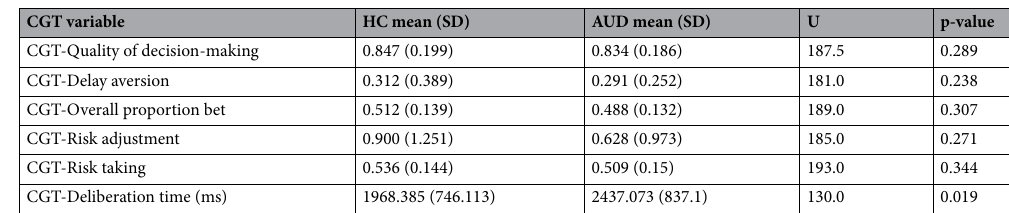
Table 2. CGT performance. For each of the 6 CGT metrics, the table reports the mean outcome (with its standard deviation) in healthy controls and individuals with AUD, alongside the results of group comparisons with a non-parametric Mann–Whitney